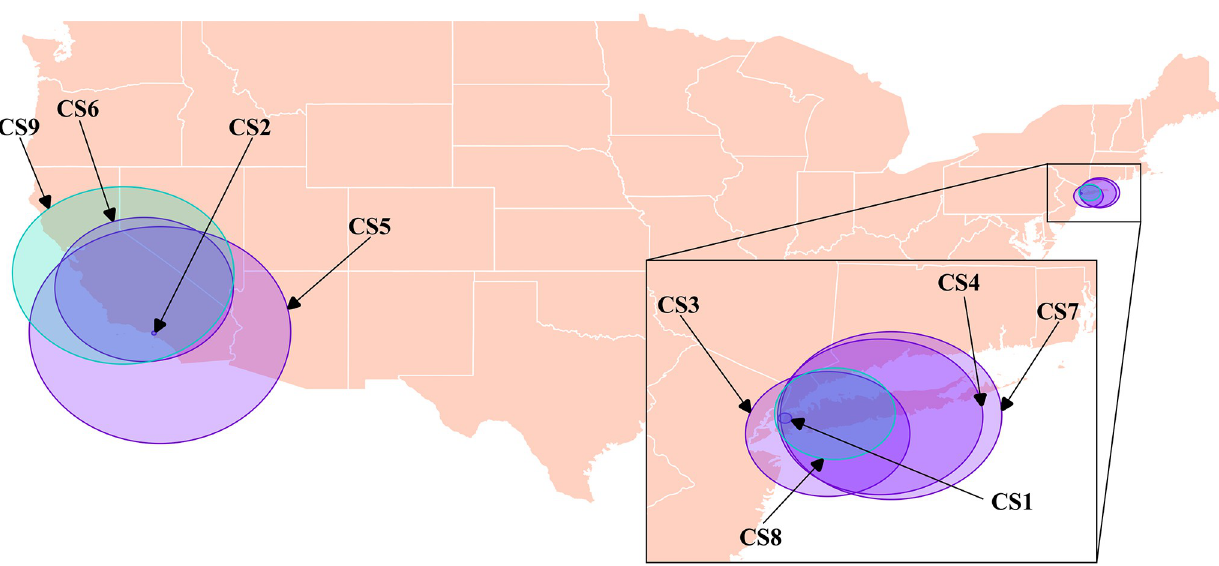
Fig 5. Locations of statistically significant spatial clusters identified with the spatial scan statistic using Bernoulli models, where there were statistically significant higher proportions of dog-associated poisoning calls to the Animal Poison Control Center related to cannabinoids in the continental US (2005–2014).